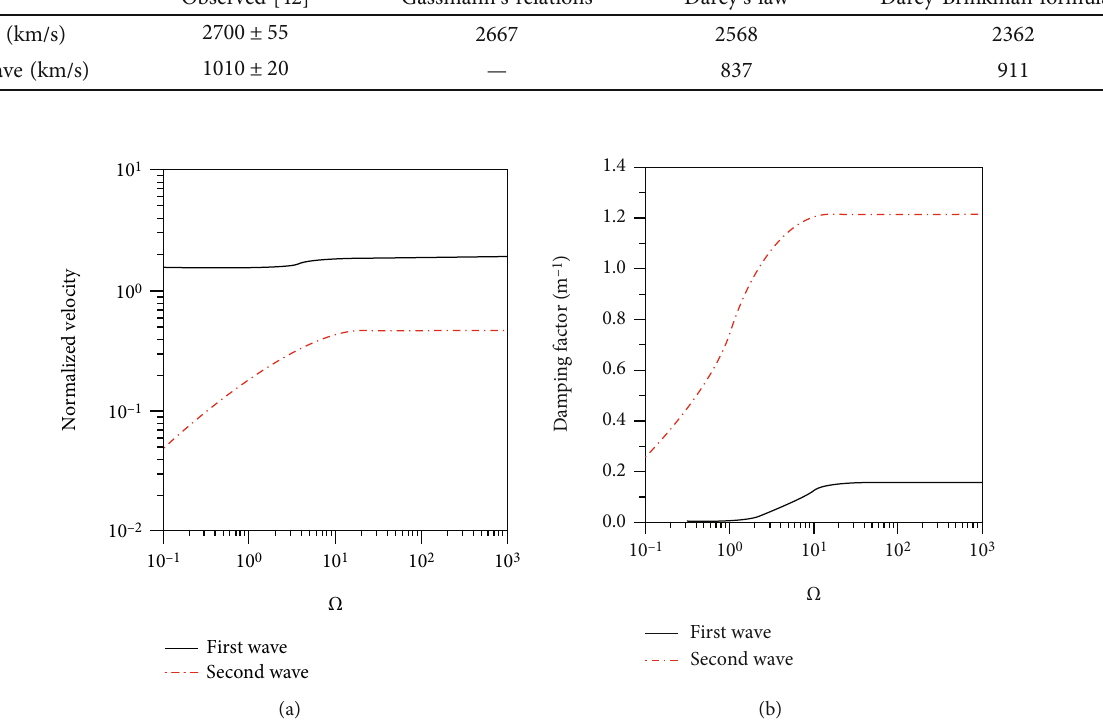
Figure 1: Velocity (a) and attenuation (b) predicted with Darcy ’ s law for the compressional waves in water- fi lled sand. The velocity is normalized by the fl uid velocity 1517m/s as a function of the normalized frequency, Ω = ω / ω c